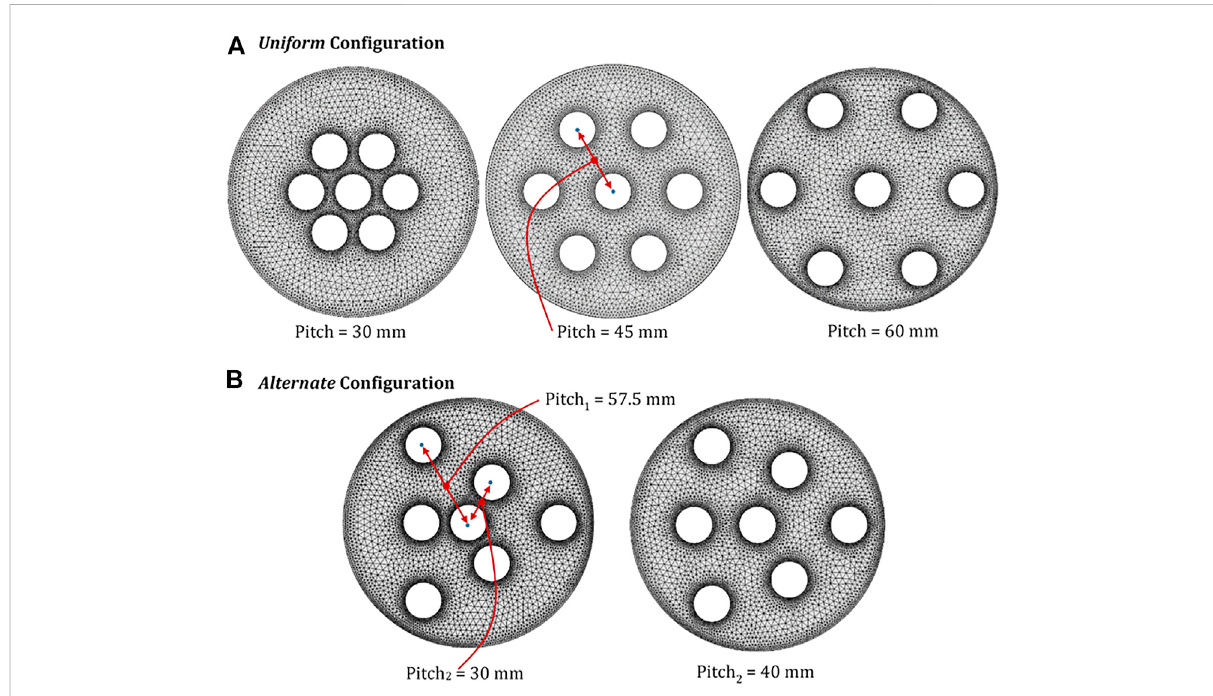
FIGURE 3 Example of computational mesh for (A) the uniform con fi gurationand (B) the alternate con fi guration for different pitch values.